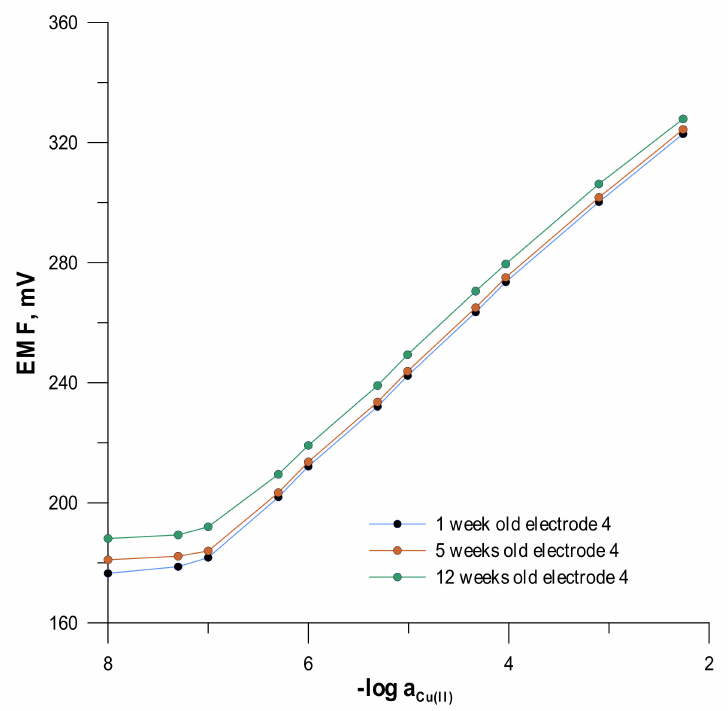
Figure 10. Change of calibration curve course in time determined for electrode